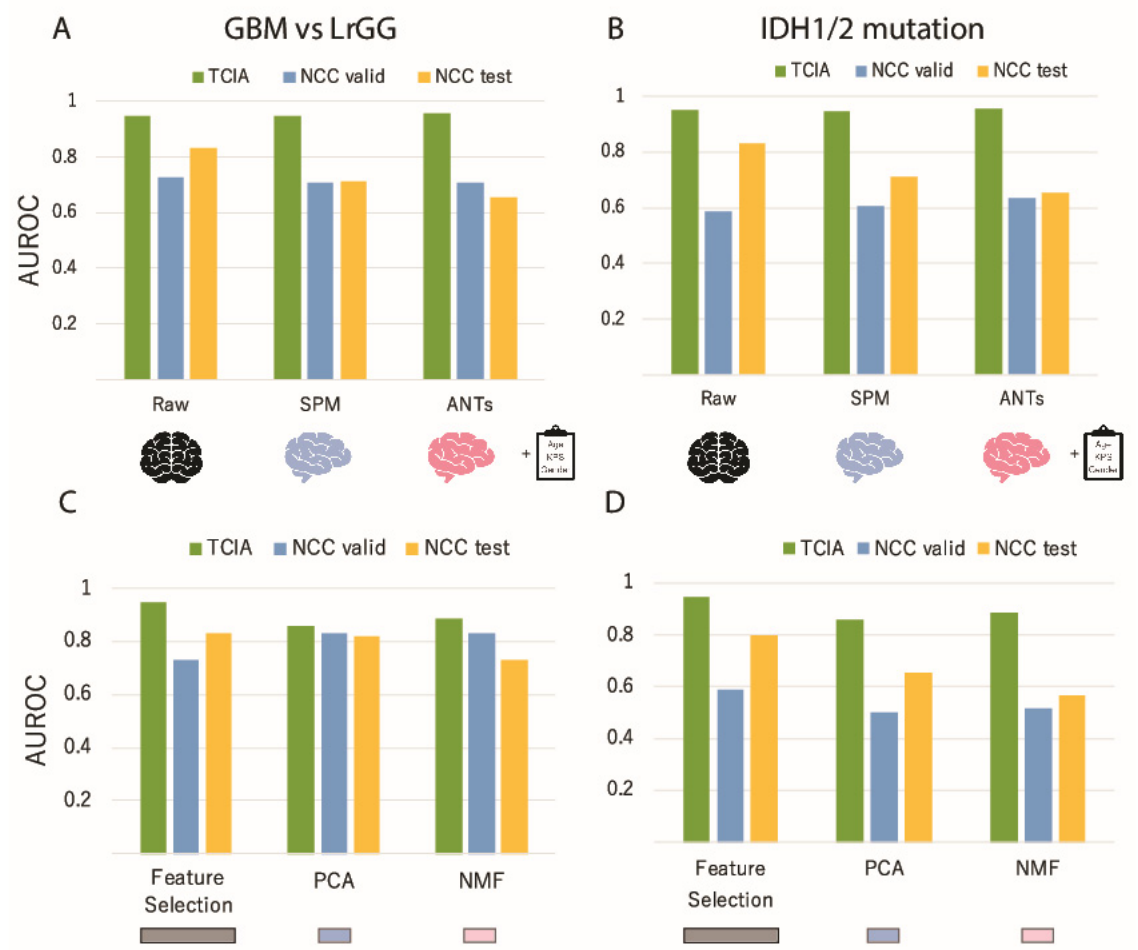
Figure 6. Changes in classification performance for GBM ( A , C ) and IDH ( B , D ) prediction due to differences between standardization and dimension reduction methods. The difference of this figure from Figure 4 is that input data comprised images as well as clinical information, whereas in Figure 4 only image features are used. ( A , B ) Comparison of accuracies due to differences in the standardization method for GBM and IDH prediction, respectively. ( C , D ), Comparison of accuracies due to differences in dimension reduction methods for GBM and IDH prediction, respectively.